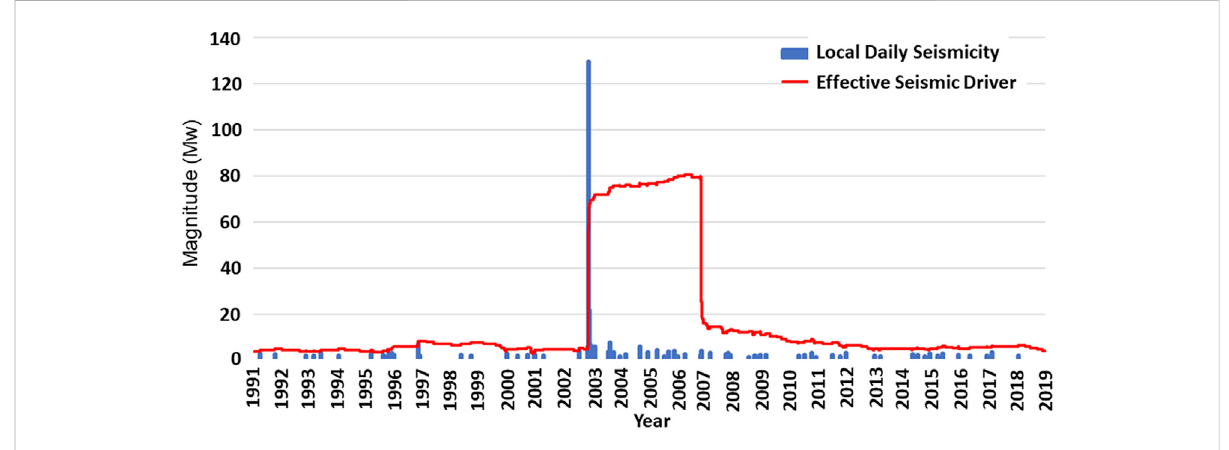
FIGURE 7 Seismic activity resulting from local and distant earthquakes projected to the center of Fels slide. Blue bars mark the daily seismic energy at the location of Fels slide. The red curve is the resulting effective seismic driver constructed using a 4-year block fi lter to re fl ect the evolution of the slide mechanics. Energy release by the 2002 Denali earthquake and its aftershocks dominates the seismic